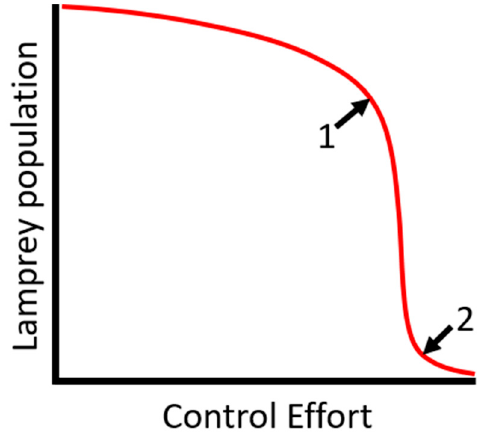
Figure 3. Conceptual representation of the relationship between the Lake Champlain sea lamprey population and efforts to control it. Point 1 indicates where benefits of population suppression begin to exceed the costs of control efforts. Point 2 indicates the beginning of diminishing returns where the costs of additional control efforts yield limited additional population suppression benefits.